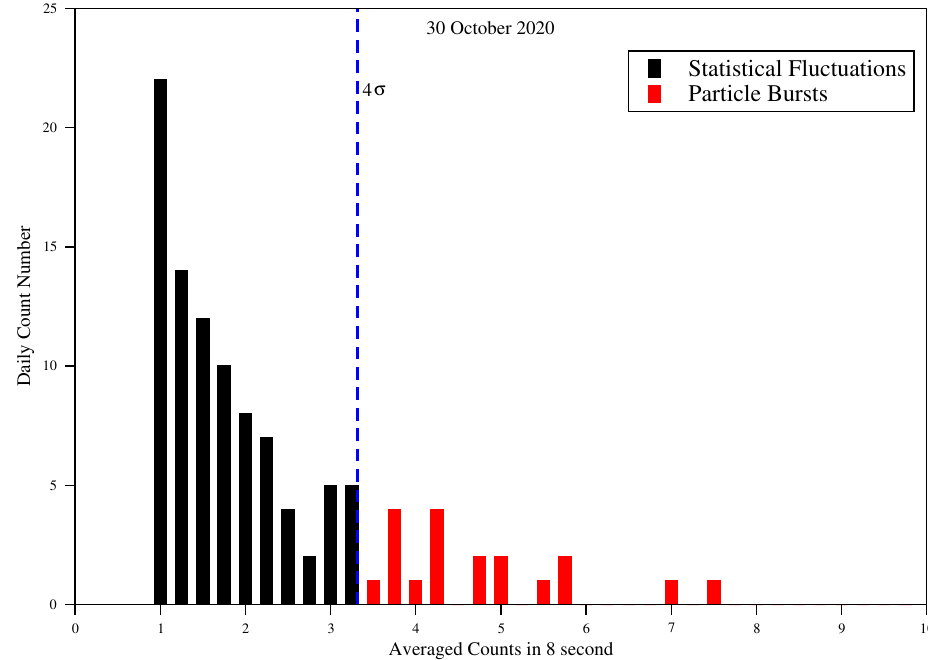
Figure 14. Distribution of averaged 8 s counts on 30 October 2020, for 0 ◦ telescope electrons with energy between 30 keV and 100 keV and with a B value ranges from 22 µ T < B < 25 µ T. The x -axis indicates the averaged counts in 8 s, and the y -axis denotes the daily count number. Here, the vertical dashed lines denote the 4 σ level. The red histograms which are over 4 σ level are treated as PB, whereas the black histograms are the normal statistical